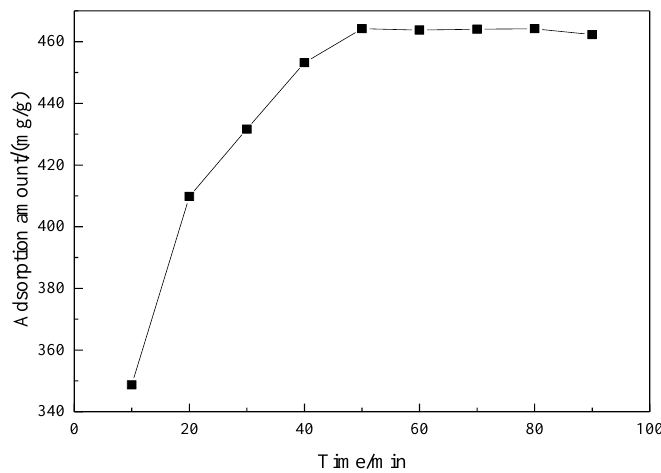
Figure 12. The influence of adsorption time on adsorption effect.